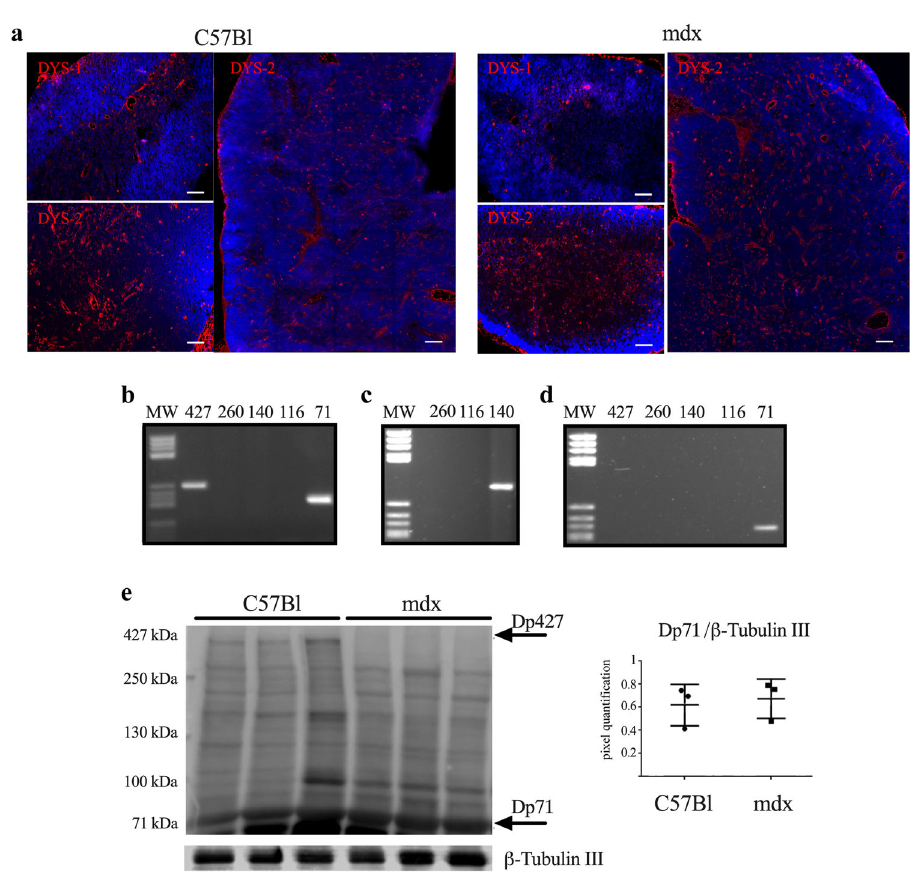
Fig. 4 Dystrophin isoforms expression in thymus of 3-month-old C57Bl and mdx mice. Confocal microscope fl uorescence images (right) and tile scan reconstructions (left) of dystrophin isoforms in thymi of C57Bl and mdx mice. DYS-1 (mid-rod-domain) (red) and DYS-2 (C-terminal-domain) (red) antibodies were used ( a ). RT-PCR analysis of the thymus of C57Bl mice determined the expression of Dp71, Dp427 dystrophin isoforms ( b ). Following the puri fi cation of the PCR products related to the isoforms Dp260 , Dp140 , and Dp116 , we performed another PCR on these samples and we found one band corresponding to Dp140 in C57Bl thymus ( c ). RT-PCR analysis of thymus of mdx mice determined the expression of the only Dp71 dystrophin isoform ( d ). WB analysis con fi rmed the absence of Dp427 dystrophin isoform in thymus of mdx mice and the presence of DP71 dystrophin isoform in thymus of both C57Bl and mdx mice ( e ). Densitometric analyses are shown as DP71/ β -Tubulin III ( e ). Scale bar: 100 μ m for tile scan reconstructions and 50 μ m for fl uorescence images ( a ). MW stands for molecular weight marker ( b – d ). Data are presented as mean ± SD of three independent experiments with n = 3. Source data are provided as a Source Data fi